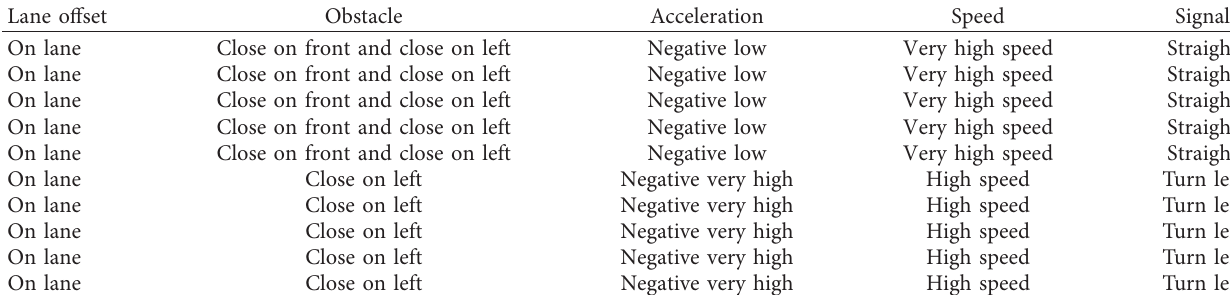
Figure 3: Words encoding model for five features of driving Table 1: The driving behavior of the sample driving data.